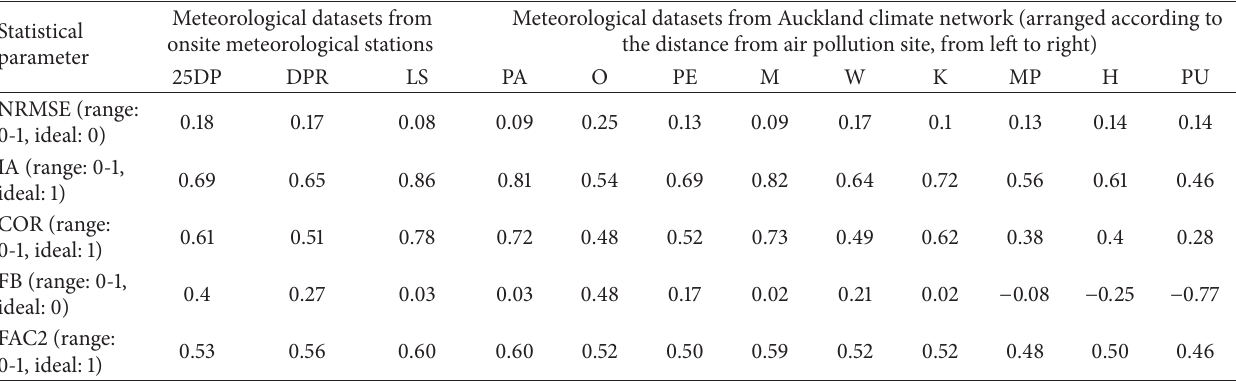
Table 4: Statistical analysis of the predicted and measured ten-minute average CO concentration at 25DP from April to July 2010. Meteorological datasets from Statistical onsite meteorological stations parameter